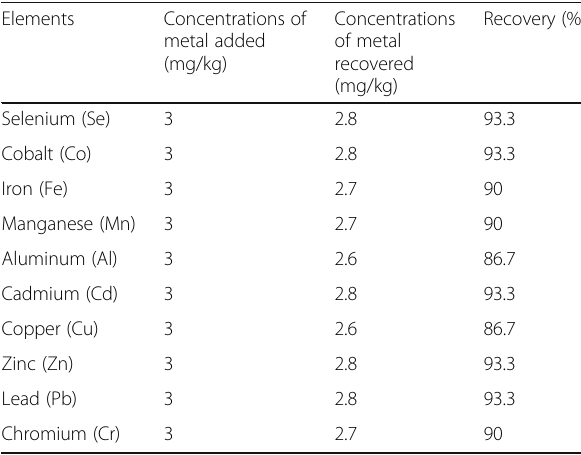
Table 4 The recovery of elements from digested nematode samples